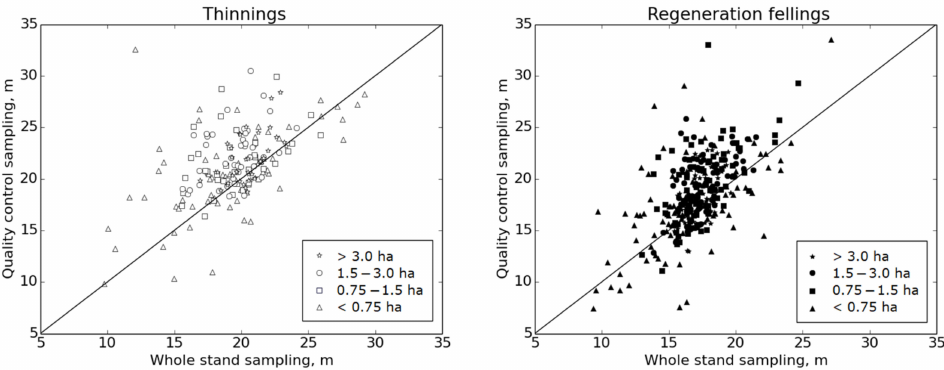
Figure 13. The average strip road spacings obtained by two different samplings. On the horizontal axis are the spacings that were sampled from the whole strip road network. On the vertical axis are the spacings using the systematic sampling of quality control measurements, where a maximum of 10 samples was